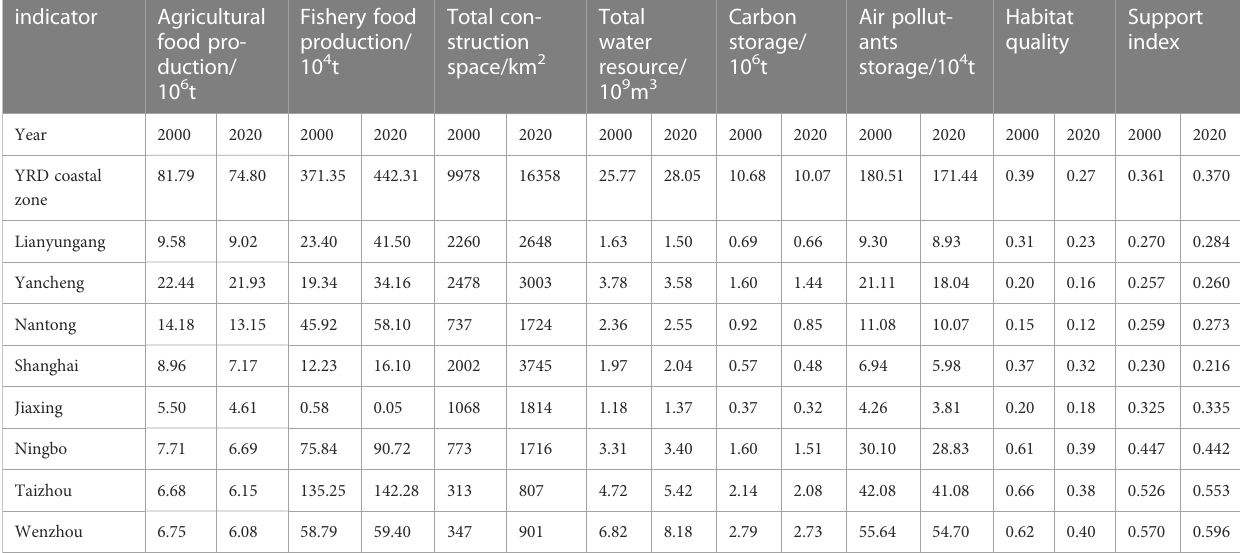
TABLE 3 Support index value in